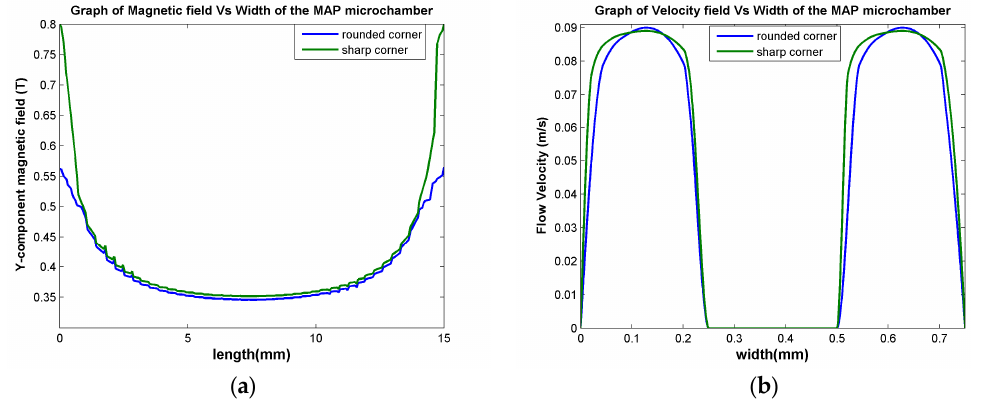
Figure 12. Graph of comparison for rounded and sharp corner: ( a ) Y-component magnetic field across the middle of the ferromagnetic track; ( b ) Average velocity field across the width of the MAP microchamber.